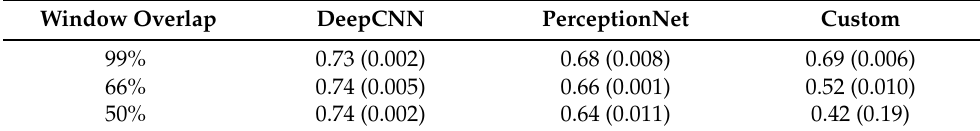
Table 4. Window overlap size effect.